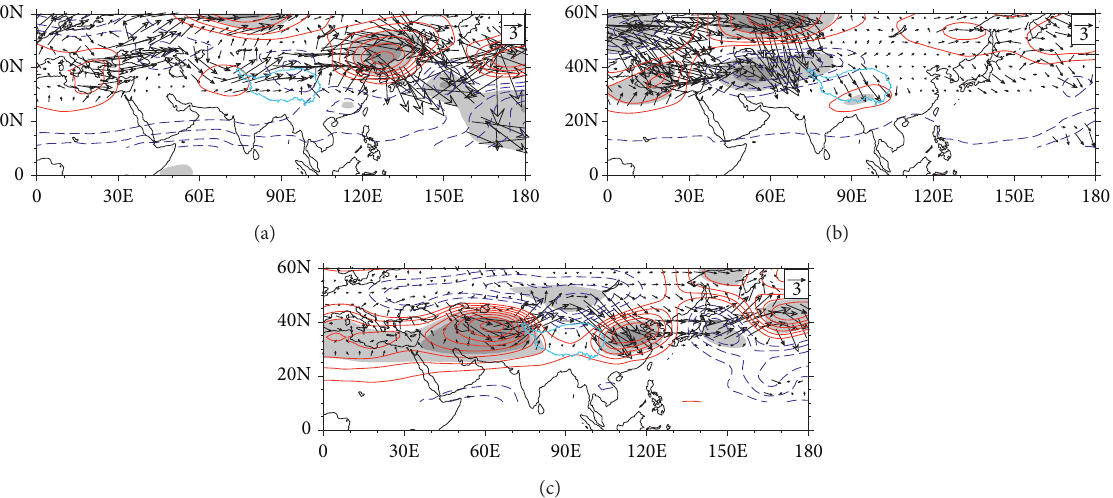
Figure 11: The linear regression pattern of the quasi-geostrophic stream function anomaly (QG) (contours, units:10 6 m 2 · s − 1 ) and T-N wave activity flux (TNF) (vectors, units: m 2 · s − 2 ) at 200hPa against (a) NCR, (b) INR, and (c) ISR. Dark (light) shadings indicate values sig- nificantly exceeding the 99% (90%) confidence level using Student’s t